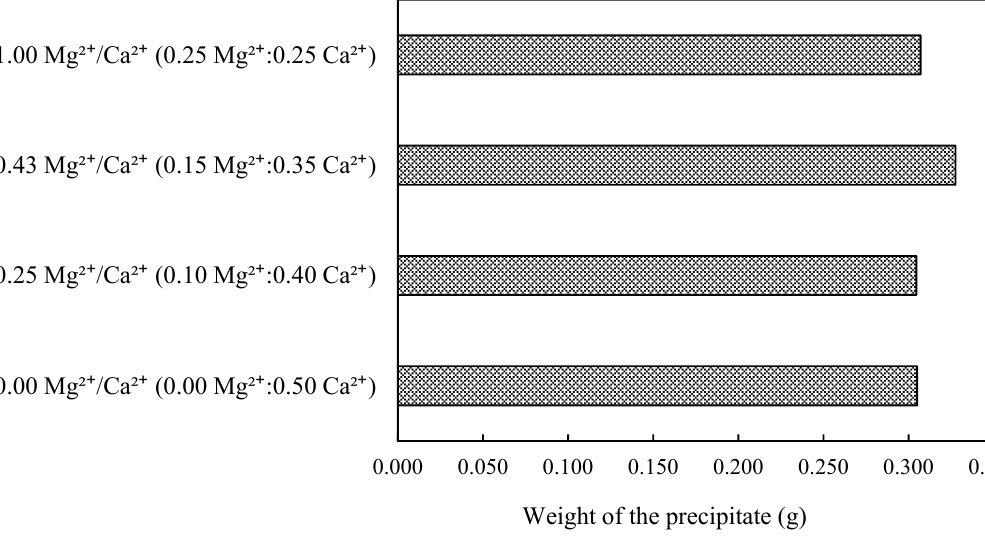
Figure 10. Variation of microbial induced carbonate precipitation under different Mg 2+ /Ca 2+ molar ratios.